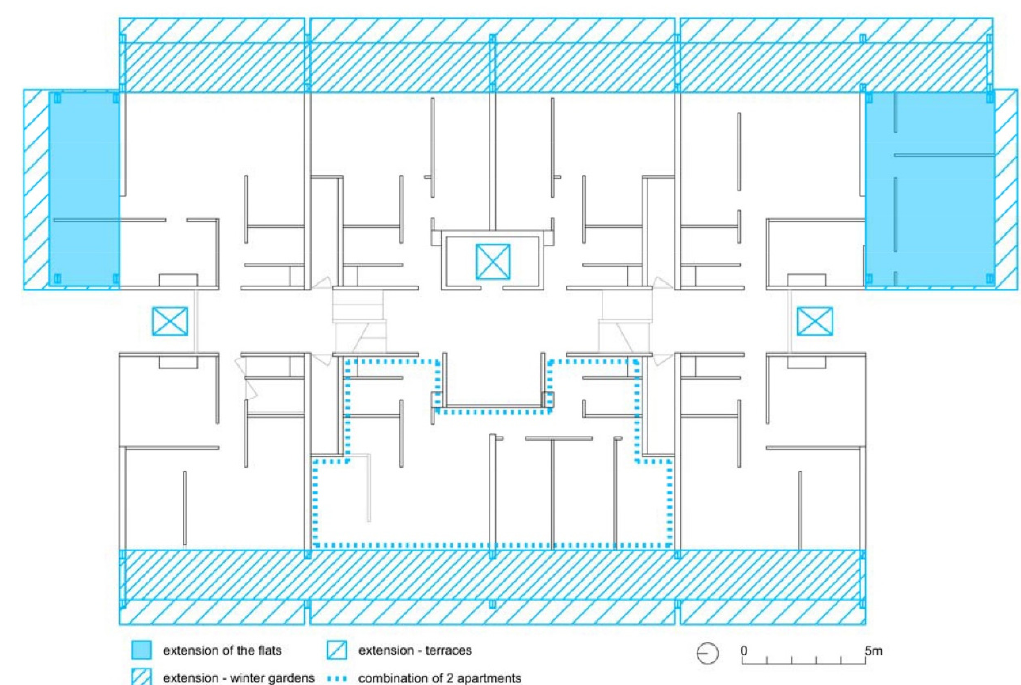
Land 2021 , 10 , x FOR PEER REVIEW